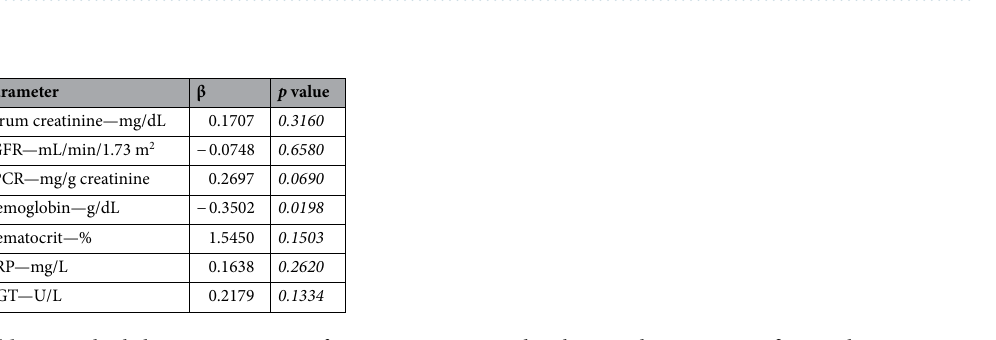
Table 4. Multiple logistic regression of parameters associated with ICU admission. Significant values are in italics.